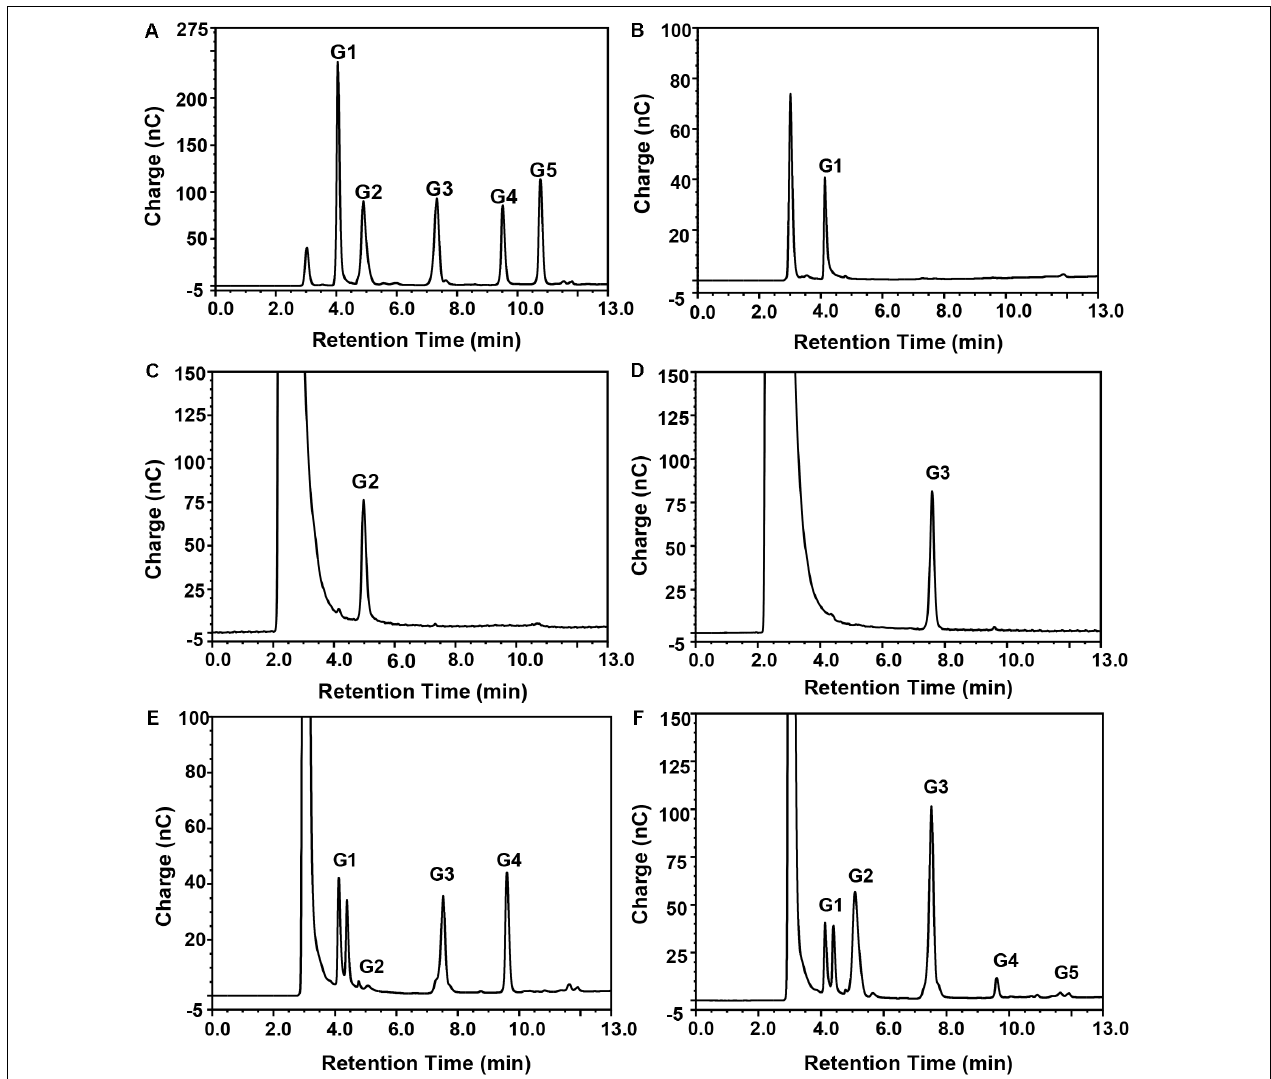
FIGURE 5 | Mode of action of purified recombinant BpEG analyzed by HPAEC-PAD. Separation of the reaction products from enzyme reactions conducted with (B) CMC-Na, (C) cellobiose, (D) cellotriose, (E) cellotetraose, or (F) cellopentaose, as described in section “Materials and Methods.” Standards (A) G1, glucose;